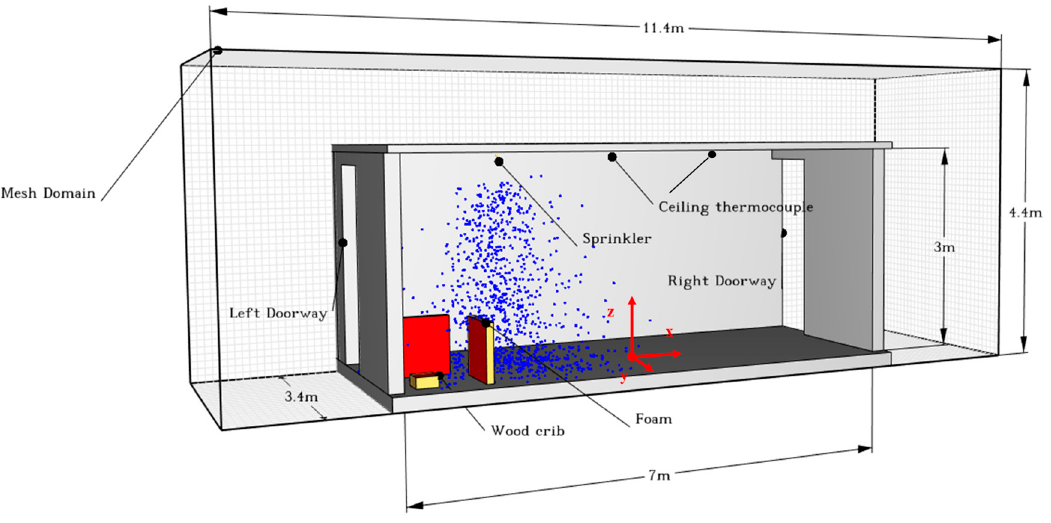
Figure 4. 3D schematic view of the compartment modeling.